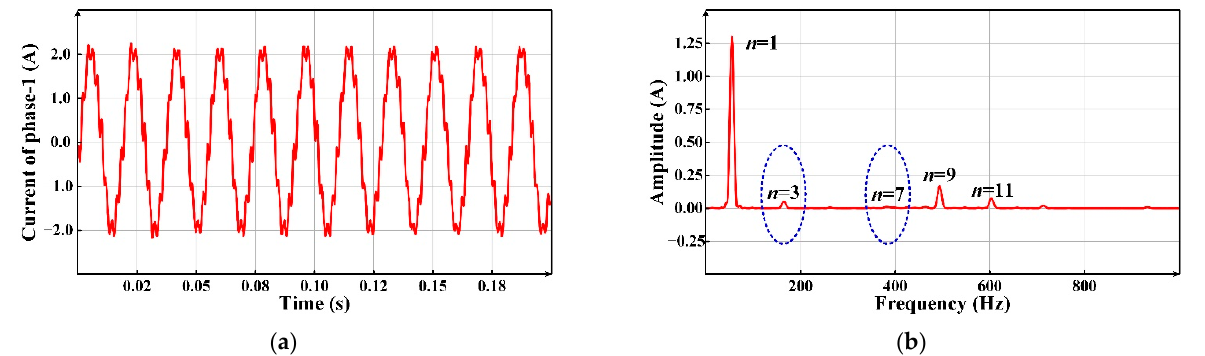
Figure 11. Harmonic current suppression results with fundamental currents and seventh harmonic current: ( a ) phase-1 current; ( b ) DFT results.